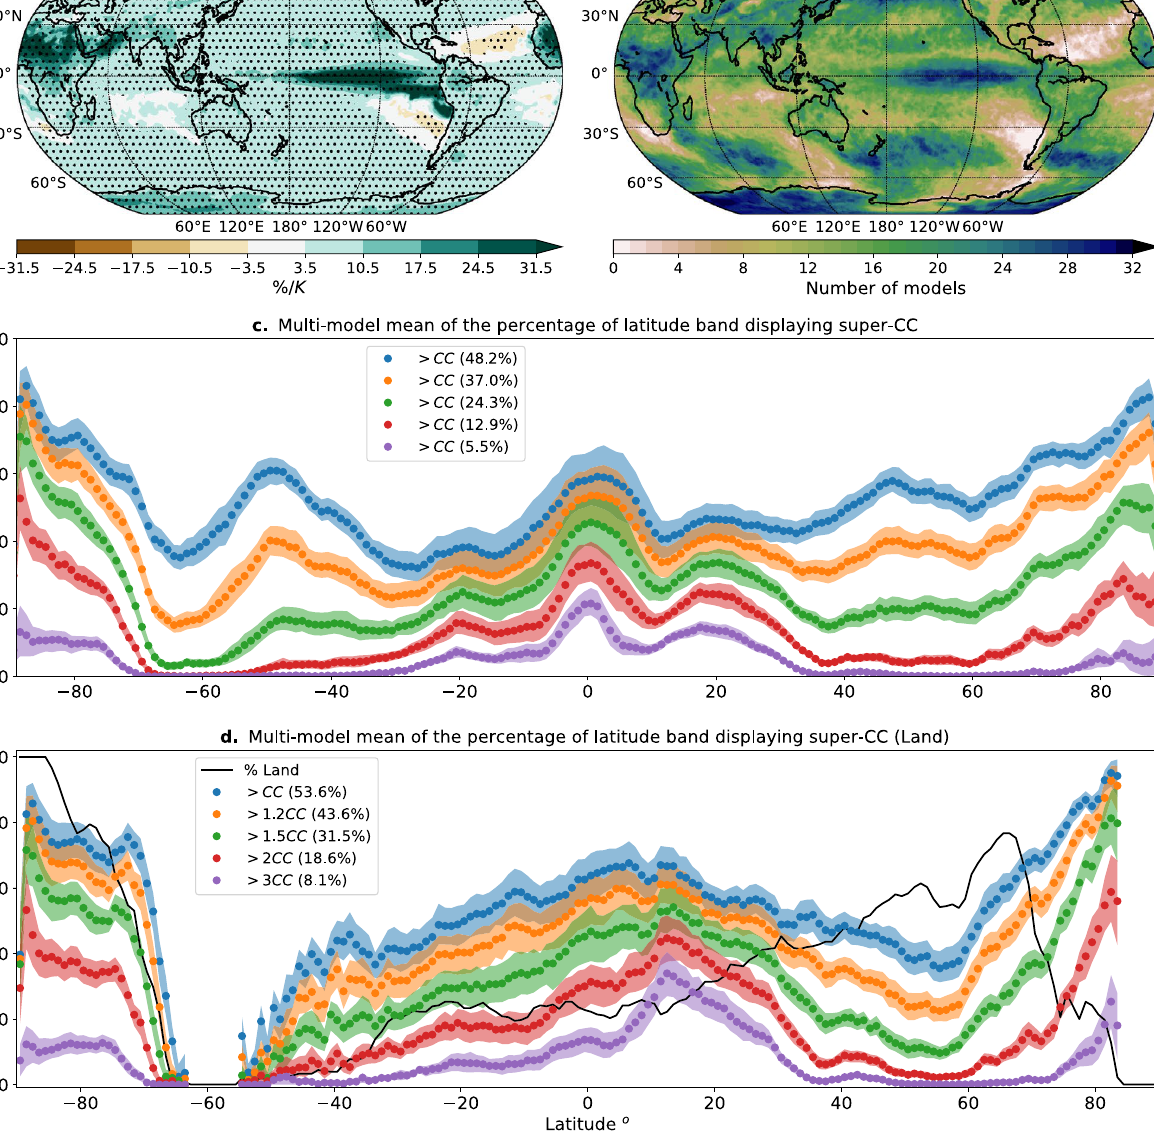
percentile-based 13,15 or annual maximum-based 52,53 work. For the conventional multi-model ensemble mean most of the regions have increases ranging between 3.5% / K and 10.5% / K , with exceptions mainly in the central and eastern Tropical Pacific (consistent with Ref. 15,54–56 ) and the Sahel and Southern Sahara that display super CC behavior (in agreement with Ref. 57 ). There are expected decreases in some subtropical regions due to enhanced divergence, including the coast off North and Central Chile and North and South subtropical Atlantic. Another traditional measure, here adapted to P L for prevalence of projected super CC behavior in CMIP6, is shown in Fig. 5b: a map of the number of models (out of 32) projecting end of the century increases above